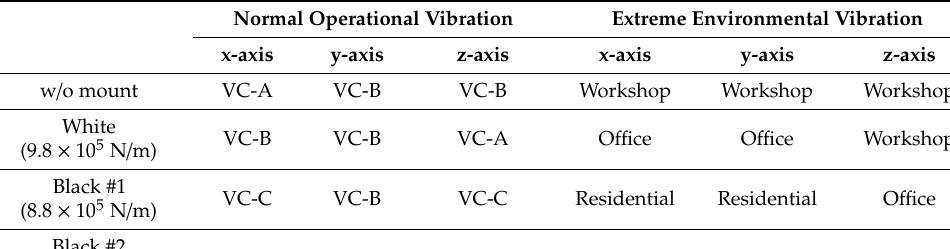
Table 1. Vibration characteristics for three di ff erent types of mounts.